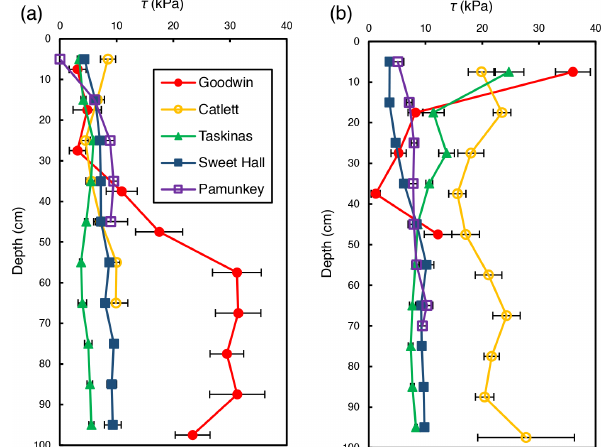
Figure 2. Average shear strength ( τ ) profiles for the marsh edge (a) and the marsh interior (b) locations at each study site. Each profile represents the average of 10 replicate profiles, and error bars repre- sent standard